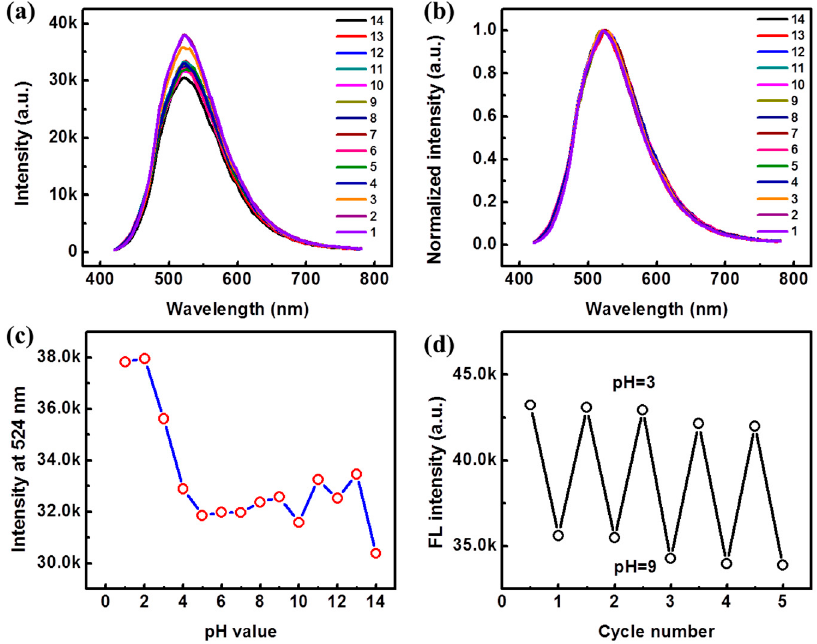
Figure 4. Fluorescence properties of Pdots-0% at various pH values: ( a ) Fluorescence spectra; ( b ) Normalized fluorescence spectra; ( c ) The evolutions of the maximum emission peak at 524 nm with various pH values; ( d ) Fluorescence intensity at 524 nm upon repeatedly switching pH between 3 and 9.